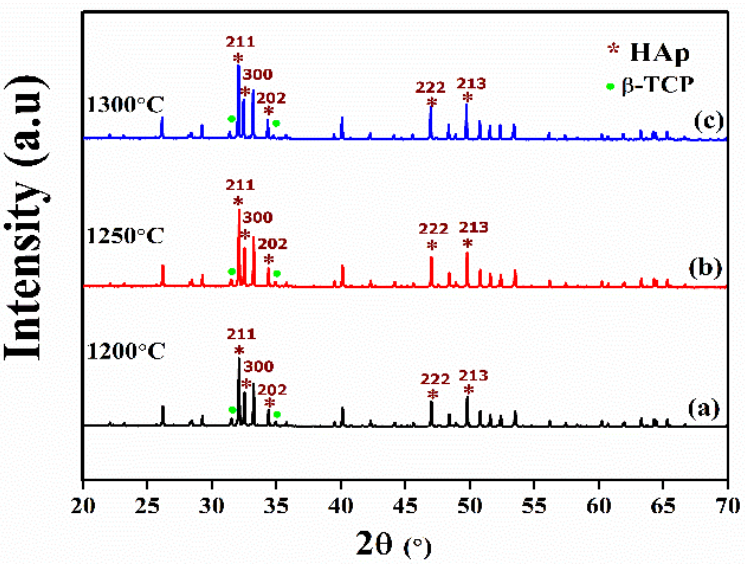
Figure 1. XRD pattern of HAp samples sintered at ( a ) 1200 °C, ( b ) 1250 °C, and ( c ) 1300 °C.